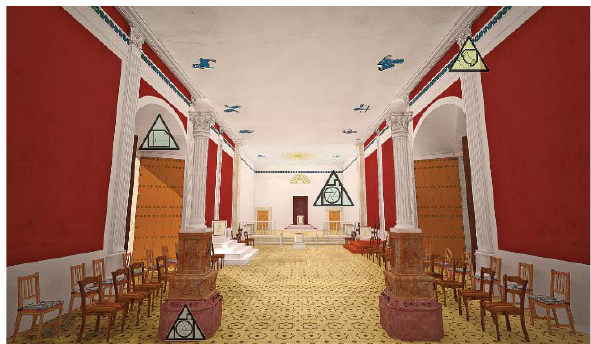
Figure 9. Interior reconstruction of the Grand Lodge The Oriental Peninsular, based on the photograph published in The Voice of the Revolution (1917) and the previous model of the temple of Jesus